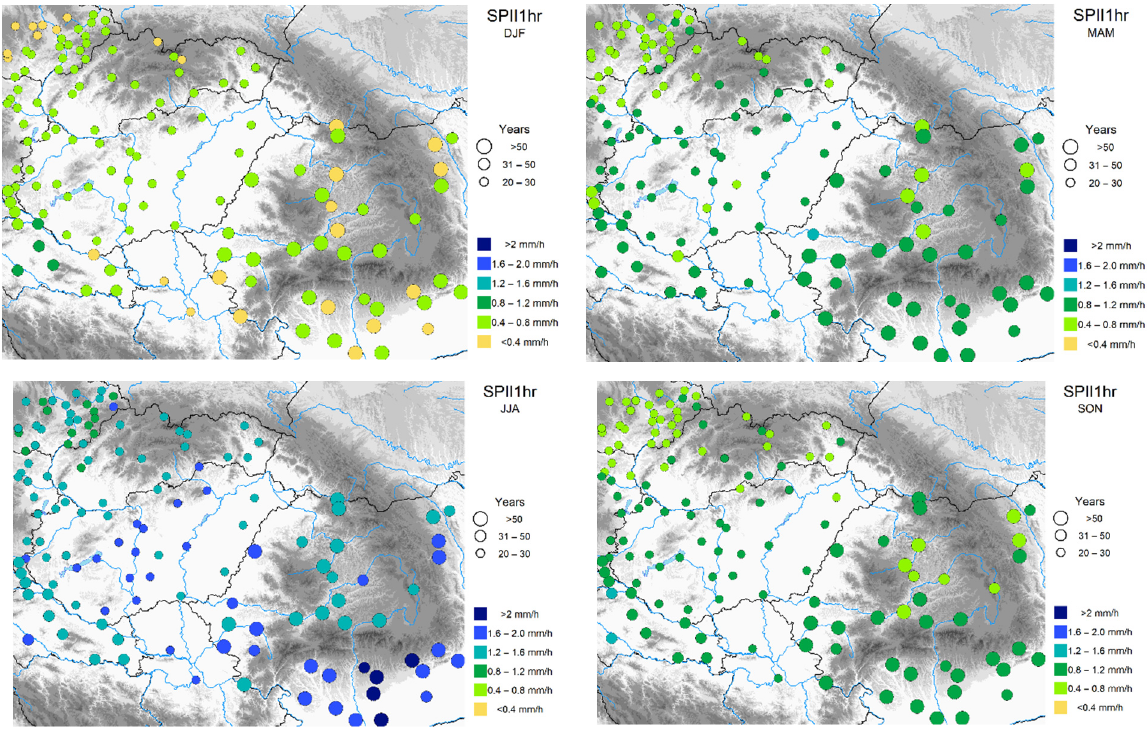
Figure 6. Seasonal (DJF–winter, MAM–spring, JJA–summer, SON–autumn) averages of the 1-h precipitation intensity (SPII1hr). The circles and their sizes are the same as in Figure 3.